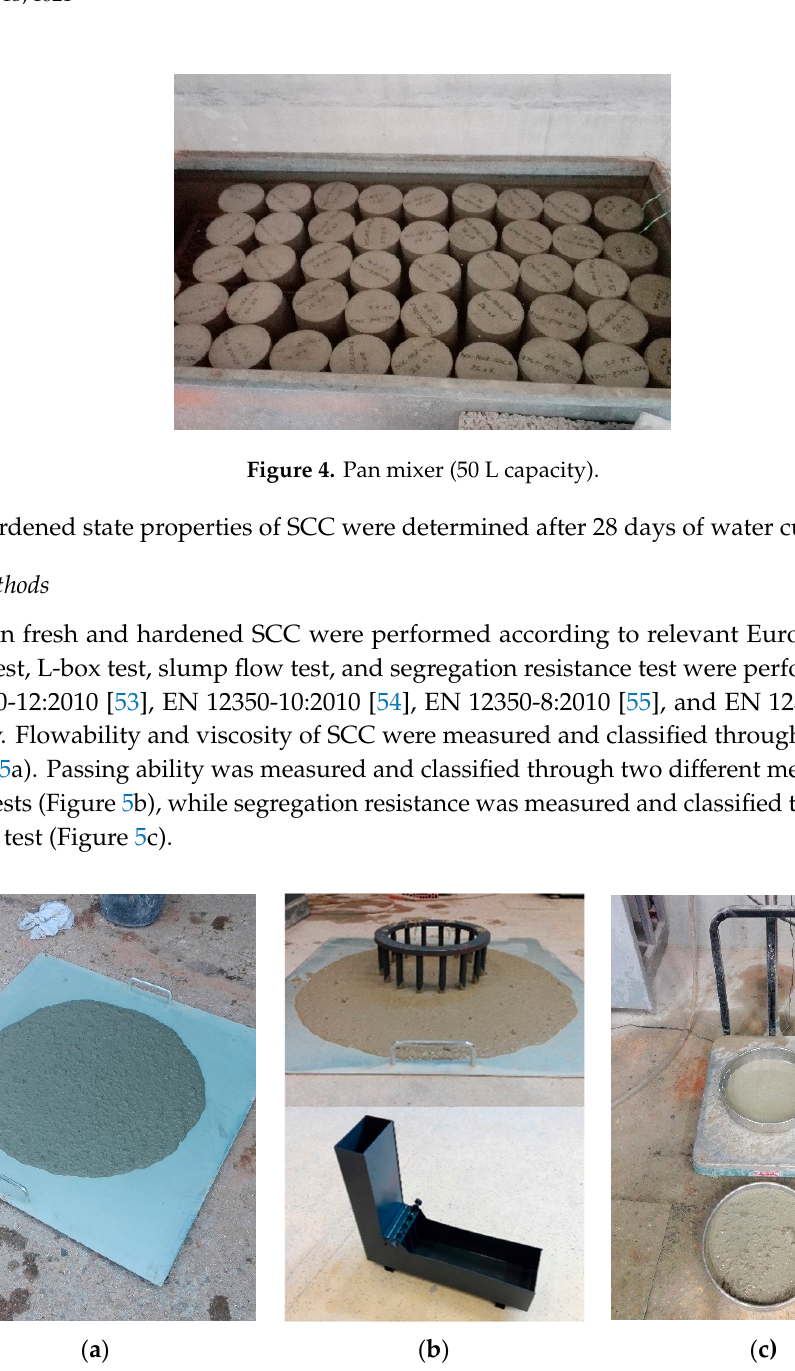
Figure 3. Pan mixer (50 L capacity).